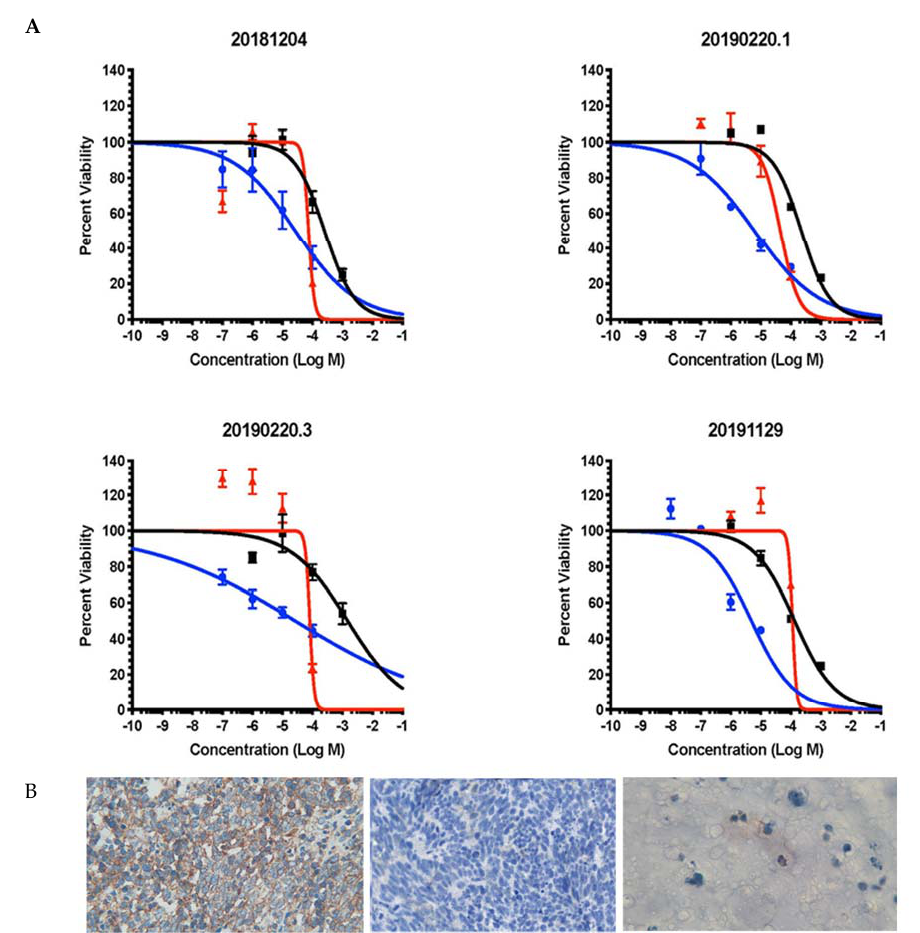
Figure 5. The second-generation polymeric fluoropyrimidine CF10 displays improved potency relative to conventional drugs in SCLC patient-derived organoids (PDOs). ( A ) Dose-response curves for CF10 (blue), cisplatin (red), and 5-FU (black) in SCLC PDOs. PDOs were developed from PDX tumors generated from four di ff erent SCLC patient biopsy samples. Aggregate data are shown in Figure S4. Aggregate IC 50 values: CF10 14.82 µ M; Cisplatin 120.7 µ M; 5-FU 381.3 µ M. CF10 vs. 5-FU: p < 0.0001; CF10 vs. cisplatin: p < 0.0026. ( B ) CD56 staining for SCLC clinical sample (left; 400 × ), PDX (middle; 400 × ), and PDO (right; 600 ×